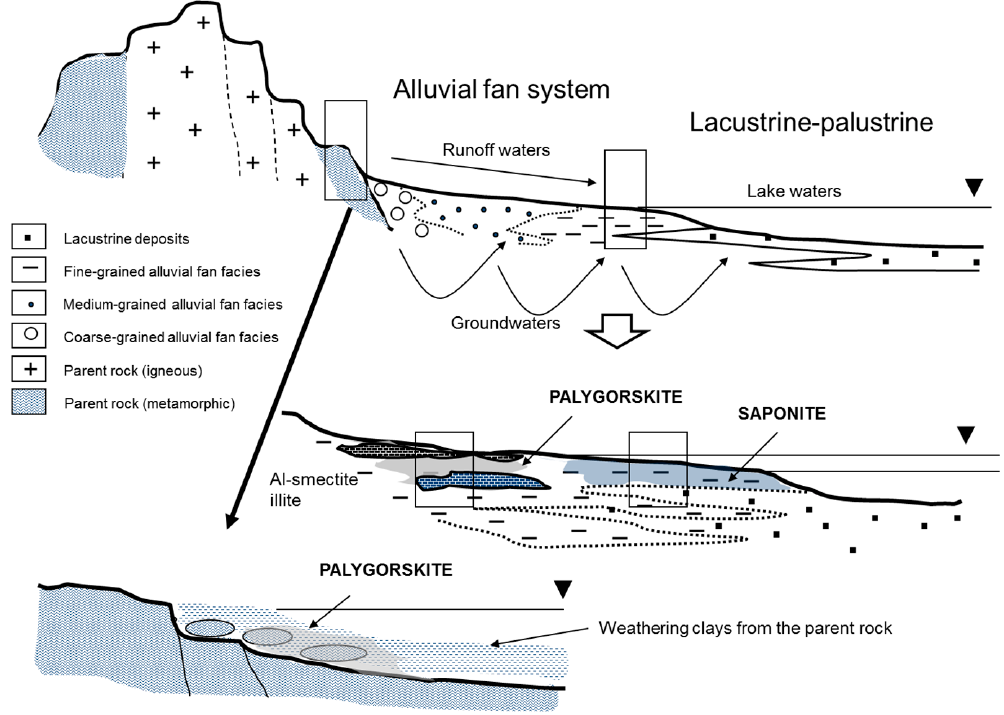
Figure 8. Idealized models proposed for the formation of palygorskite and saponite deposits in continental sedimentary environments from [78].